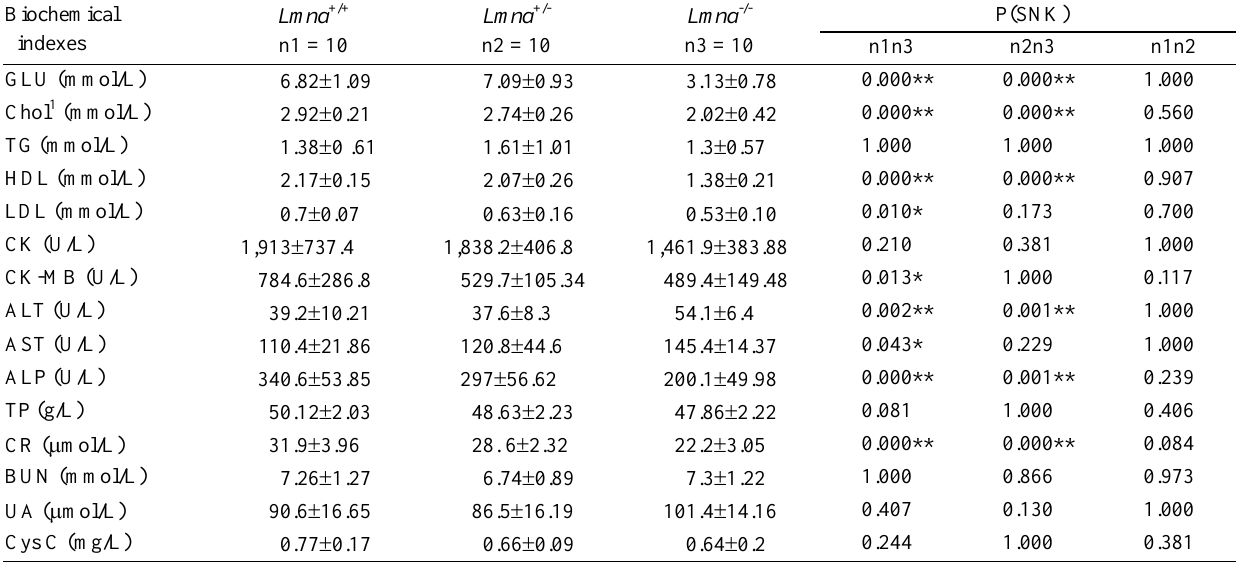
Table 1. Serum biochemical analytes (mean  SD) measured in C57BL/6 mice with the genotypes Lmna +/+ , Lmna +/- and Lmna -/- Biochemical